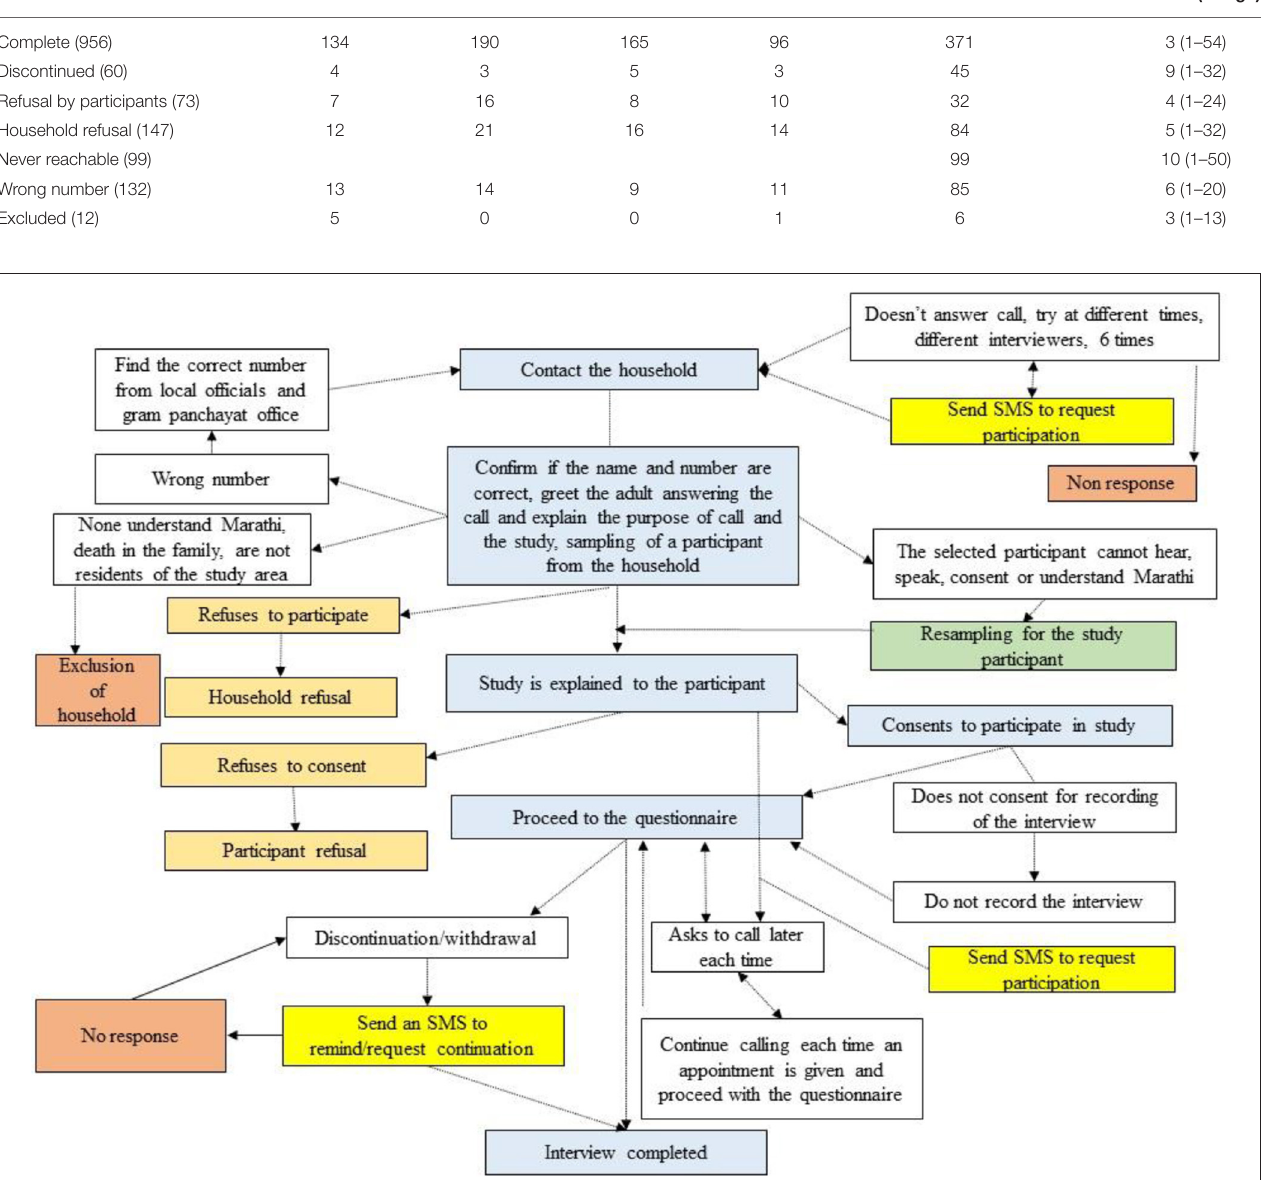
FIGURE 1 | The steps involved in contacting a household, selecting a participant, and completing the